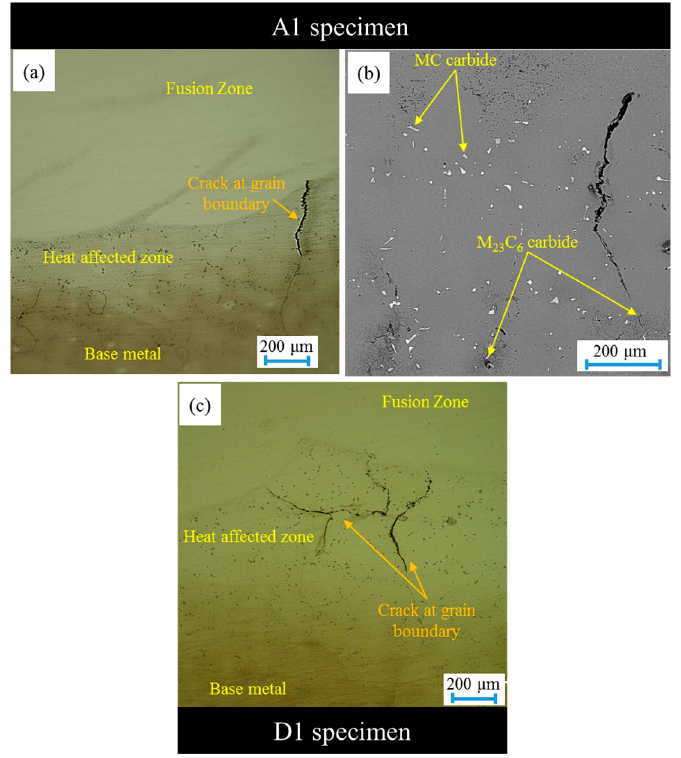
Figure 10. Cross-section view of the welded specimen; ( a ) different welding zones as the result of welding in A1 sample, ( b ) higher magnification of intergranular liquation crack and carbides in HAZ of A1 sample and ( c ) intergranular liquation crack formed in the HAZ of D1 sample.